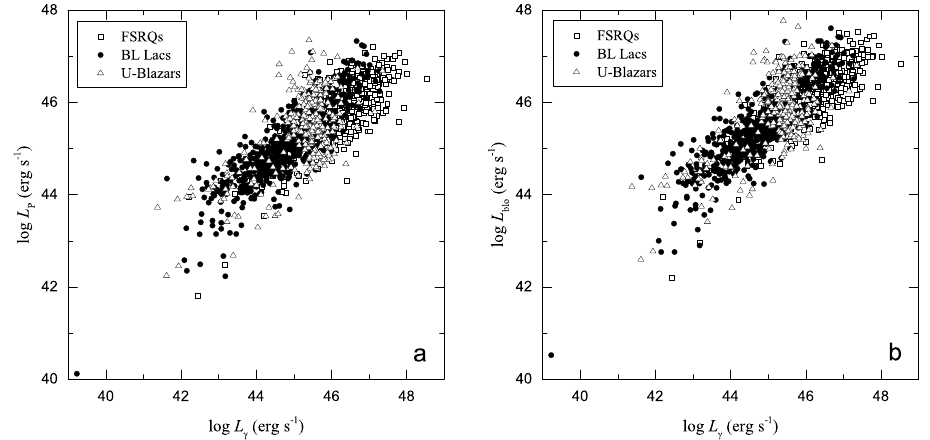
Figure 3. The correlations between γ -ray luminosity (log L γ at 1 GeV) and peak luminosity (log L p ) ( a ); and bolometric luminosity (log L bol ) ( b ).